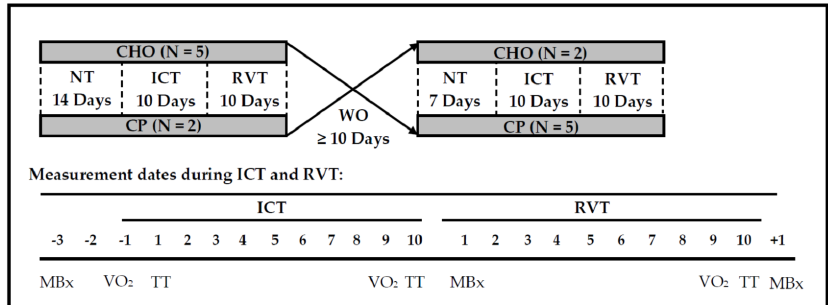
Figure 1. General Study Design. NT = normal training; ICT = intensified cycle training (daily training duration = ~220% NT); RVT = reduced volume training (~65% of NT); WO = washout; CHO = carbohydrate supplementation; CP = carbohydrate + protein supplementation; MBx = Muscle function and biopsy; VO 2 = VO 2peak ; TT = Cycling time trial, constant ‐ load exercise, and blood biomarkers.